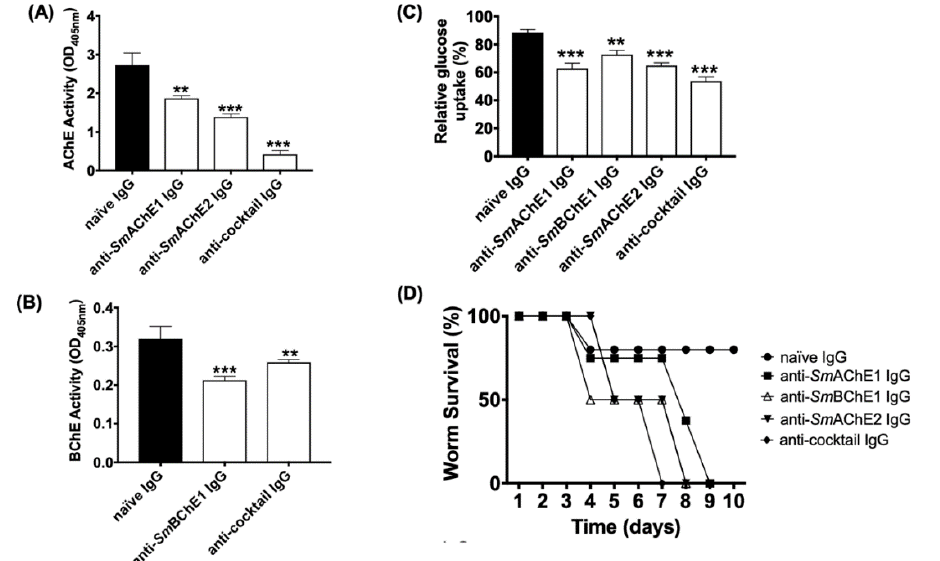
Figure 2. Effects of anti- Sm ChE antibodies on adult Schistosoma mansoni worms. Ten pairs of freshly perfused worms were incubated in the presence of anti- Sm ChE purified IgG in DMEM at 37 °C and 5% CO 2 . Naïve IgG served as a negative control. (A) AChE activity 24 h after treatment. (B) BChE activity 24 h after treatment. (C) Glucose uptake over 24 h, one day after treatment. (D) Survivability up to 10 days after treatment. The results are the mean ± SEM of two biological and three technical replicates (A-C) or two biological replicates (D). Significance (relative to the naïve IgG control) determined by the student’s t test, where * p ≤ 0.05, ** p ≤ 0.01, and *** p ≤ 0.001.